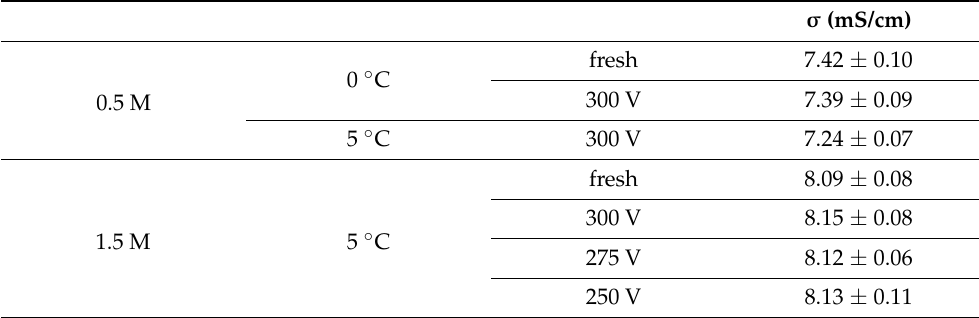
Table 4. Electric conductivity ( σ ) of citric acid water solutions measured directly after the electrolyte preparation (“fresh” solution) and after the subsequent anodizing processes (arranged sequentially from up to down the